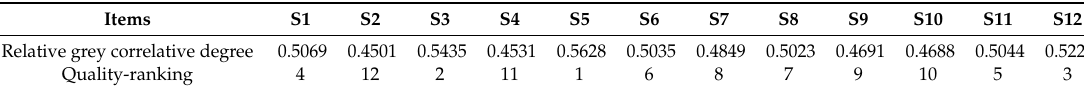
Table 6. Quality sequencing of the